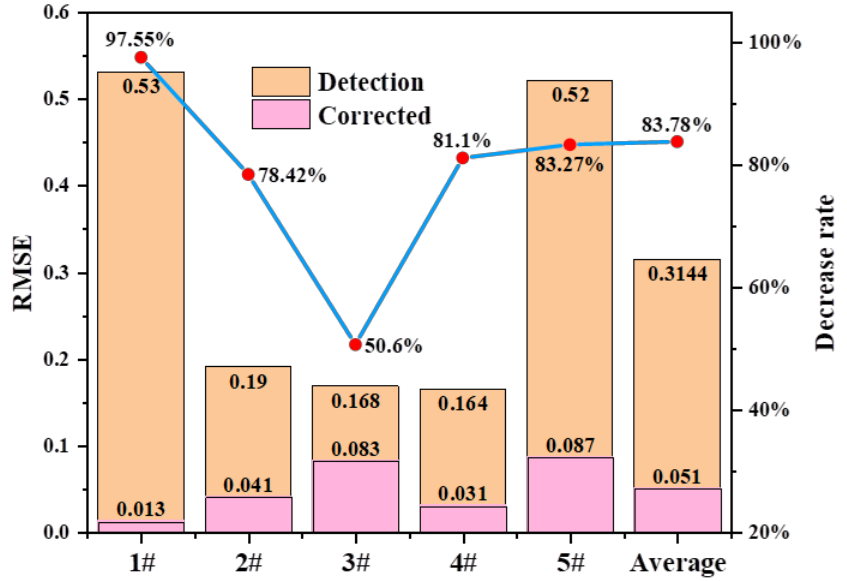
Figure 17. RMSE before and after correction of the five groups of experimental data.